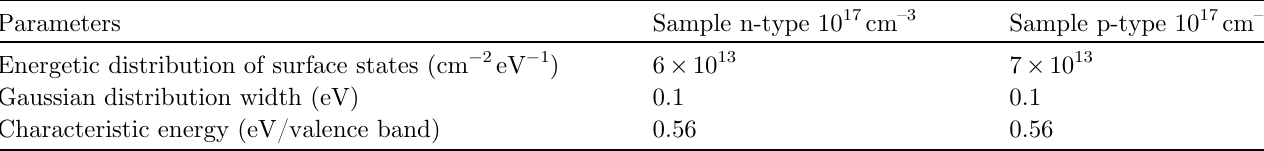
Table 1. Surface defect parameters extracted from the simulations used in Figure 3. Parameters